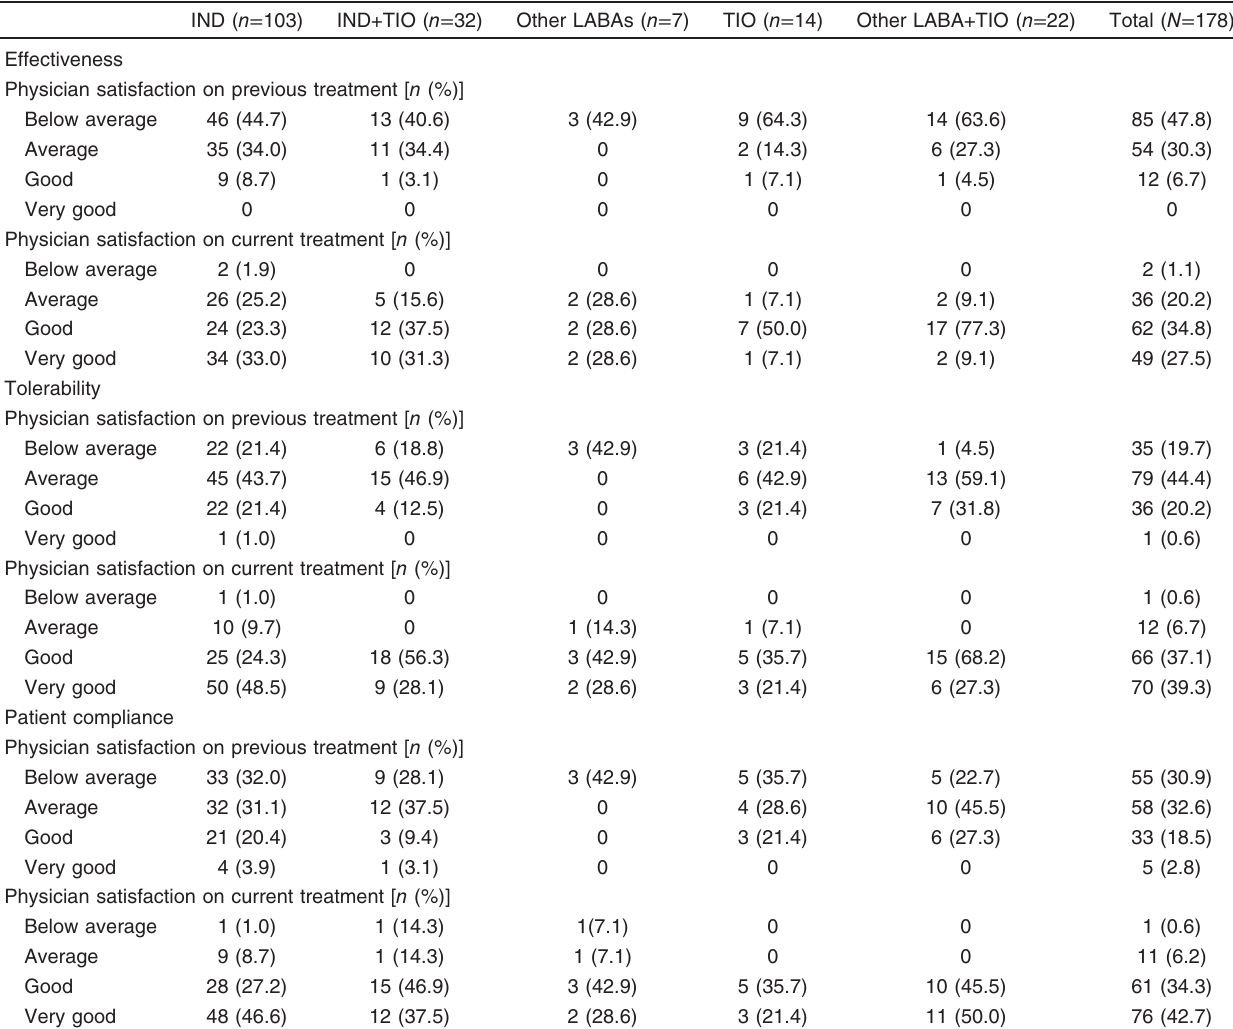
Table 3 Physician satisfaction with previous treatment and current